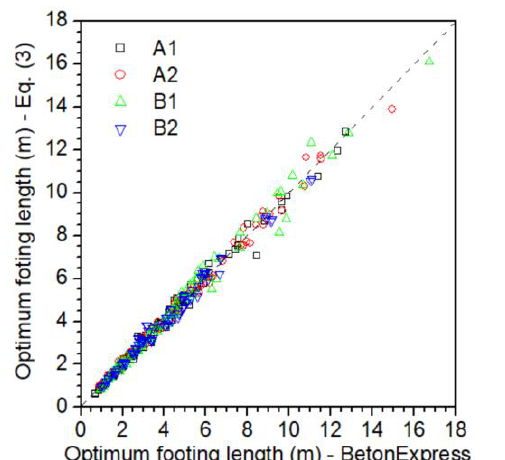
Table 3. Optimization results. Parameter